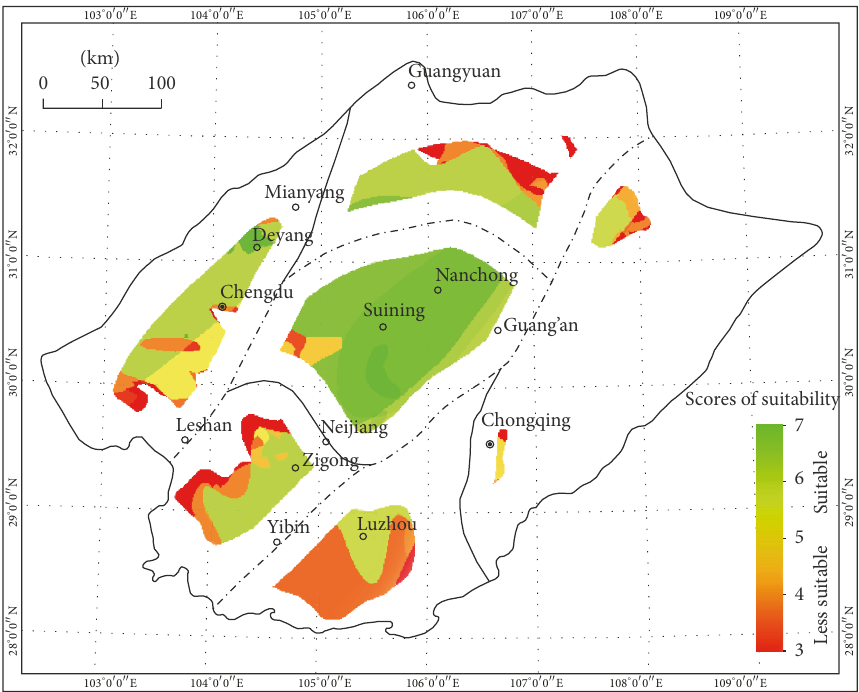
Figure 8: Assessment results of CO 2 geological storage suitability (suitable area is the “target area”). Most prospective areas in the Sichuan Basin are suitable for CO 2 geological storage, which could be the “target areas” for CO 2 geological storage. The main reservoirs in the Central Sichuan Basin are sections two, four, and six of Xujiahe formation with large thickness and good physical properties. They are far from the basin boundary faults, with weak hydrodynamic and good geological safety